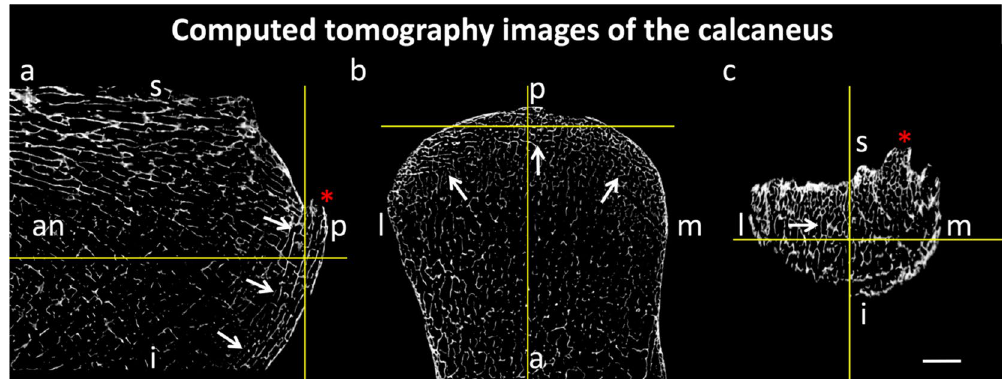
Figure 7. Computed tomography images of the calcaneus are depicted. The aligned dense trabeculae (white arrows) within the superficial posterior calcaneus are shown in a sagittal ( a ), transverse ( b ) and coronal ( c ) plane (white arrows). The center of the yellow cross marks the same spatial point within the three different planes. an anterior; i, inferior; l lateral; m medial; p posterior; s superior; red asterisk, calcaneal spur; scale bar: 5